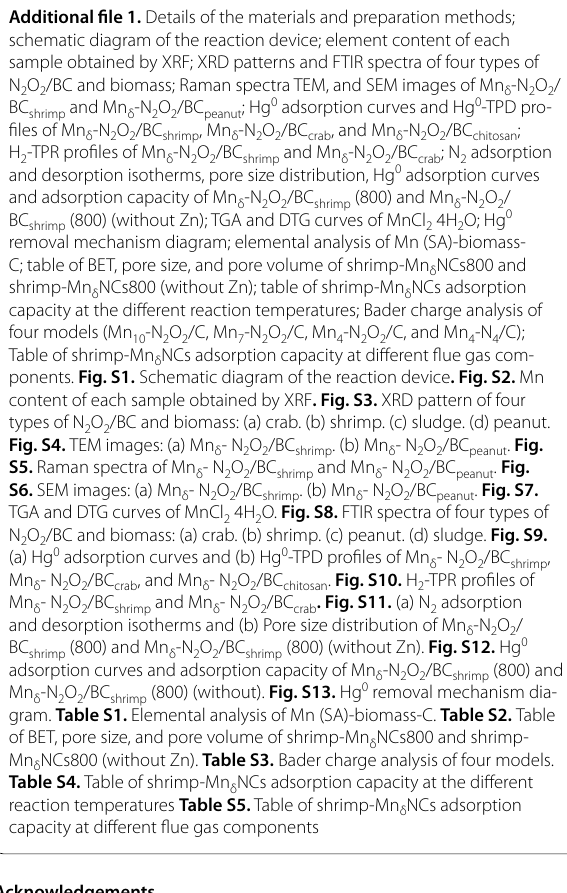
ponents. Fig. S1. Schematic diagram of the reaction device . Fig. S2. Mn content of each sample obtained by XRF . Fig. S3. XRD pattern of four types of N 2 O 2 /BC and biomass: (a) crab. (b) shrimp. (c) sludge. (d) peanut. Fig. S4. TEM images: (a) Mn δ - N 2 O 2 /BC shrimp . (b) Mn δ - N 2 O 2 /BC peanut . Fig. S5. Raman spectra of Mn δ - N 2 O 2 /BC shrimp and Mn δ - N 2 O 2 /BC peanut . Fig. S6. SEM images: (a) Mn δ - N 2 O 2 /BC shrimp . (b) Mn δ - N 2 O 2 /BC peanut . Fig.